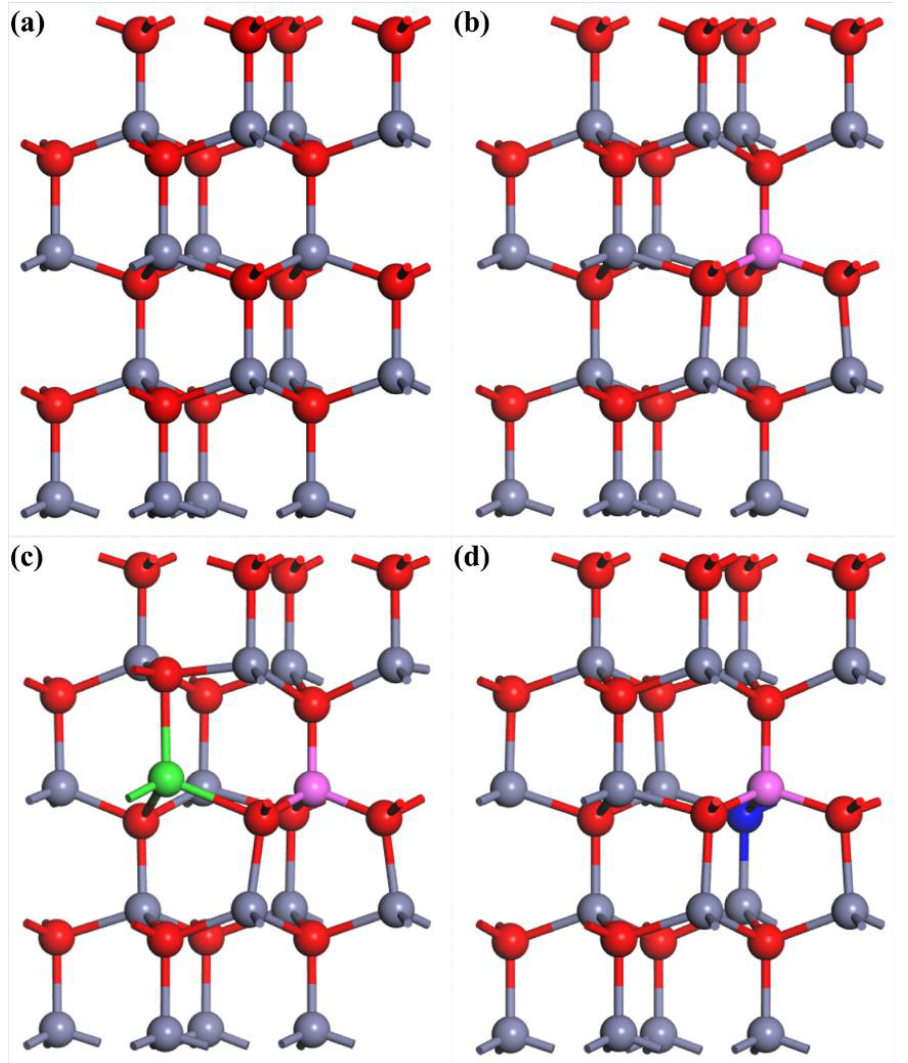
Figure 1. Optimized 2 × 2 × 2 supercell of ZnO ( a ), metal single doping ZnO (Al-ZnO) ( b ), metal/metal co-doping ZnO (Al/Ag-ZnO) ( c ), and metal/non-metal co-doping ZnO (Al/N-ZnO) ( d ), and the red, gray, pink, green, and blue spheres represent oxygen, zinc, aluminum, silver, and nitrogen atoms, respectively.